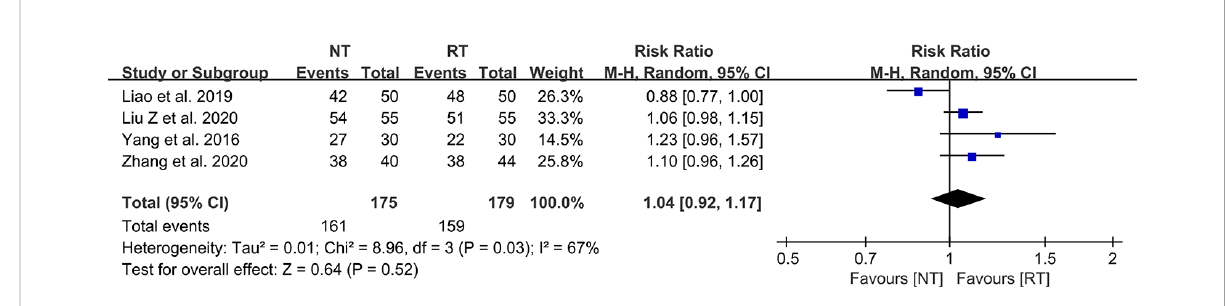
FIGURE 7 Meta-analysis of wound healing satisfaction between the NT and RT groups. NT, no routine chest tube drainage; RT, routine chest tube drainage; CI, con fi dence